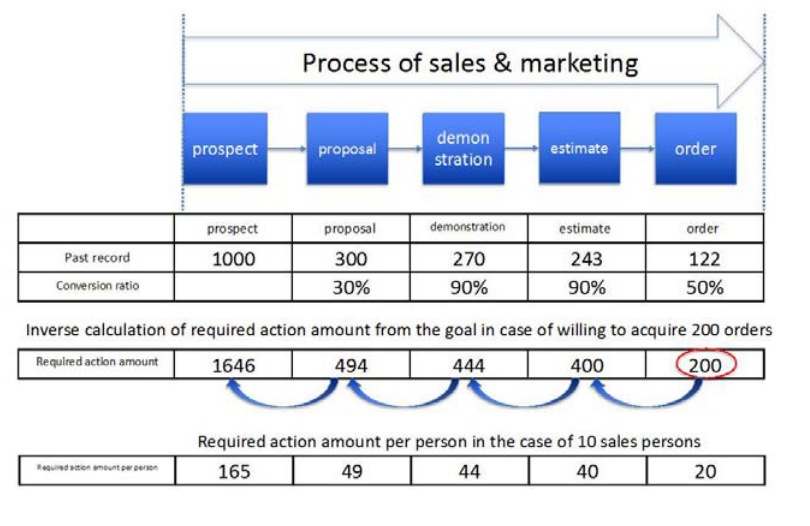
Figure 1. Back calculation from